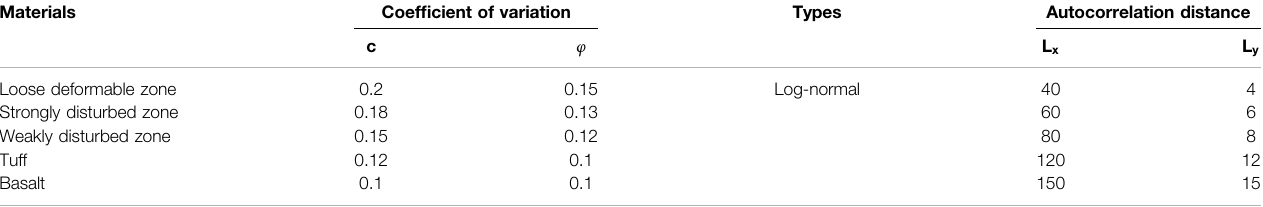
TABLE 3 | Statistical characteristics of the shear strength parameters. Materials